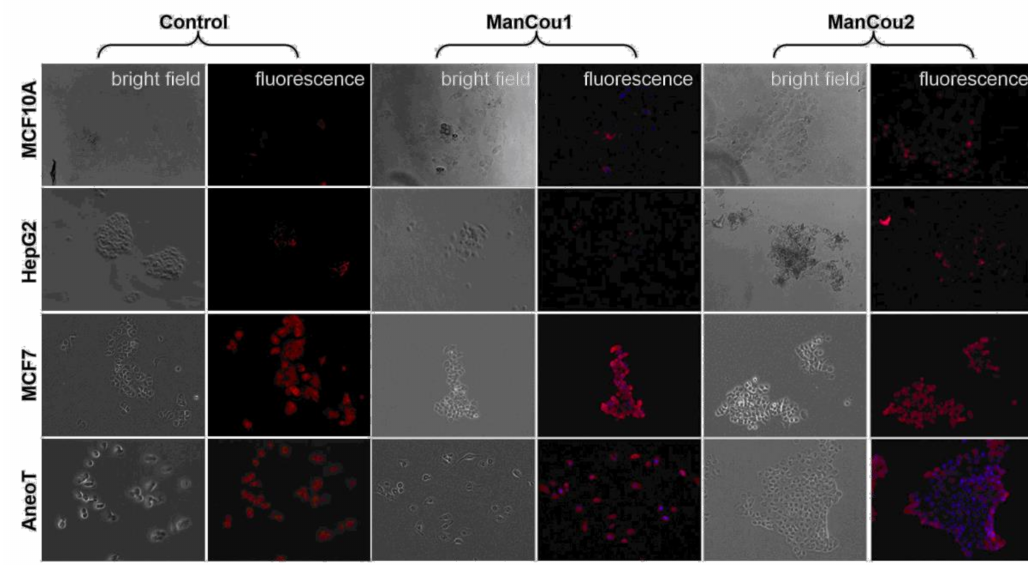
Figure 6. Immunostaining of cells for GLUT5 without and with ManCous. Optical microscopy, 20 × . “Control” panel represents GLUT5 staining. “ManCou1” and “ManCou2” panels represent GLUT5 staining after 10 min treatment of cells with the respective probes. The red fluorescence represents GLUT5 (Texas Red ® . Ex: 596 nm, Em: 620 nm) and blue (DAPI) represents the probe. The cells were incubated with 20 µ M of the respective probes for 10 min and fixed in paraformaldehyde before immunostaining. Images were captured using EVOS FL Auto immediately following